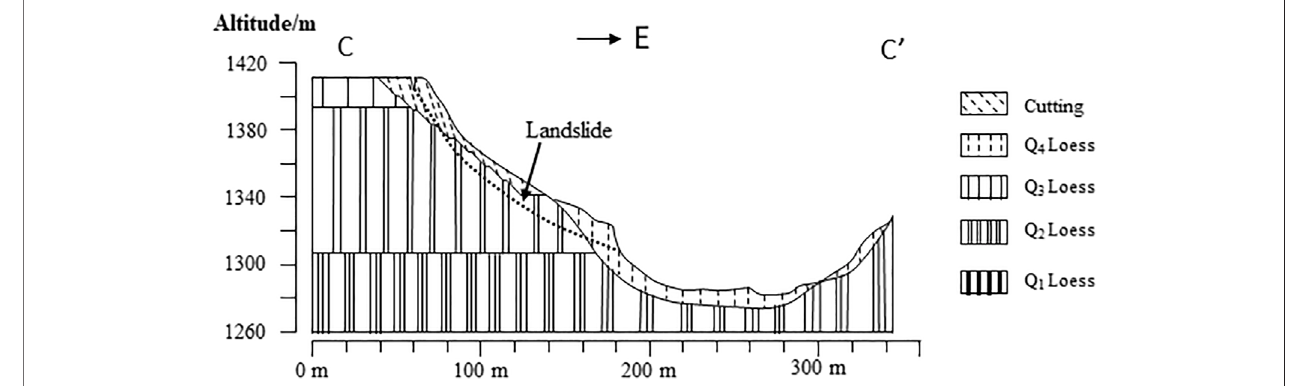
FIGURE 10 | C – C ′ pro fi le across the stabilization of unstable slope.